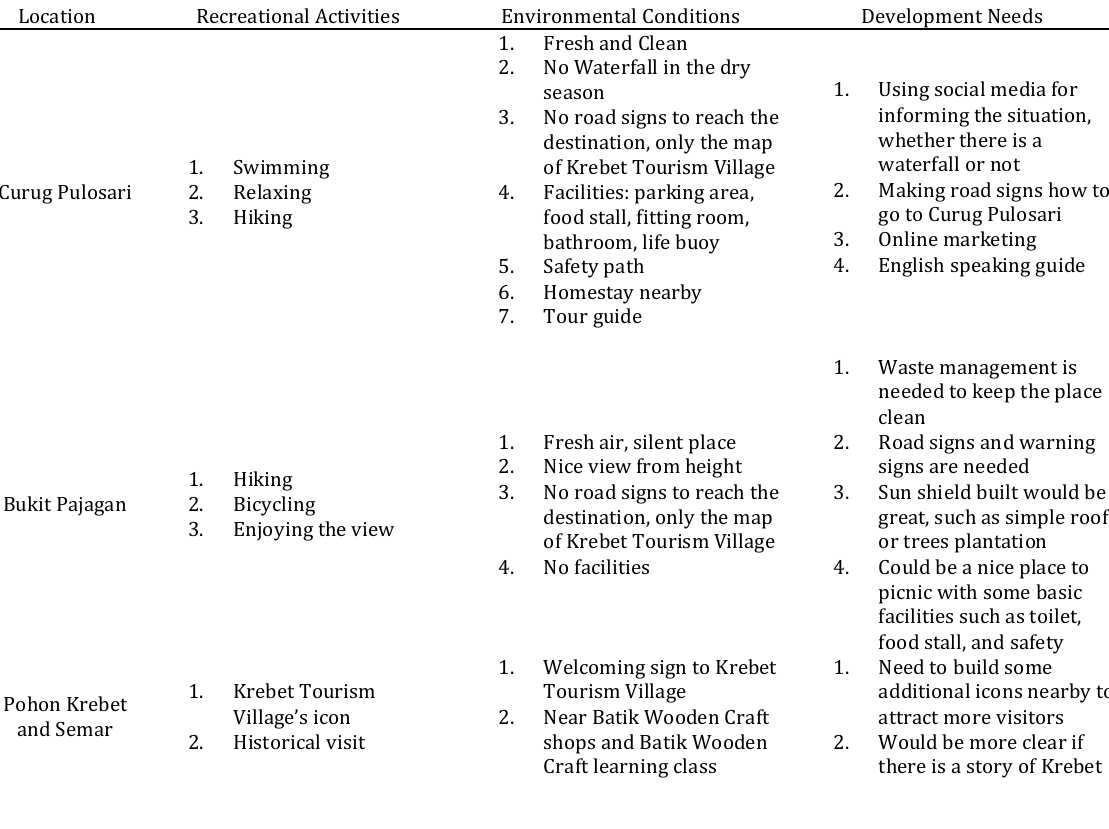
Table 1 Tourist Attractions in Krebet